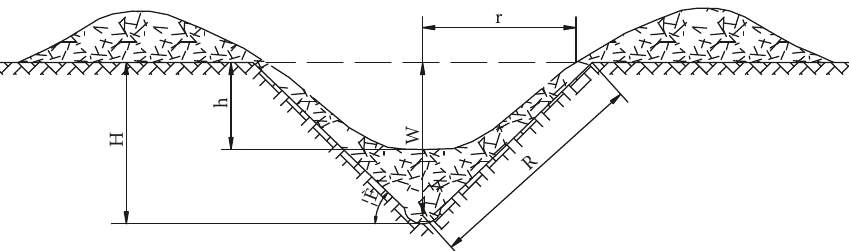
Figure 1: Blasting crater schematic . r-Radius of the blasting crater; W-minimum resistant line; R-blasting crater crashed radius; h-visible depth of the blasting crater; H-depth of the blasting crater; 𝜃 -crater